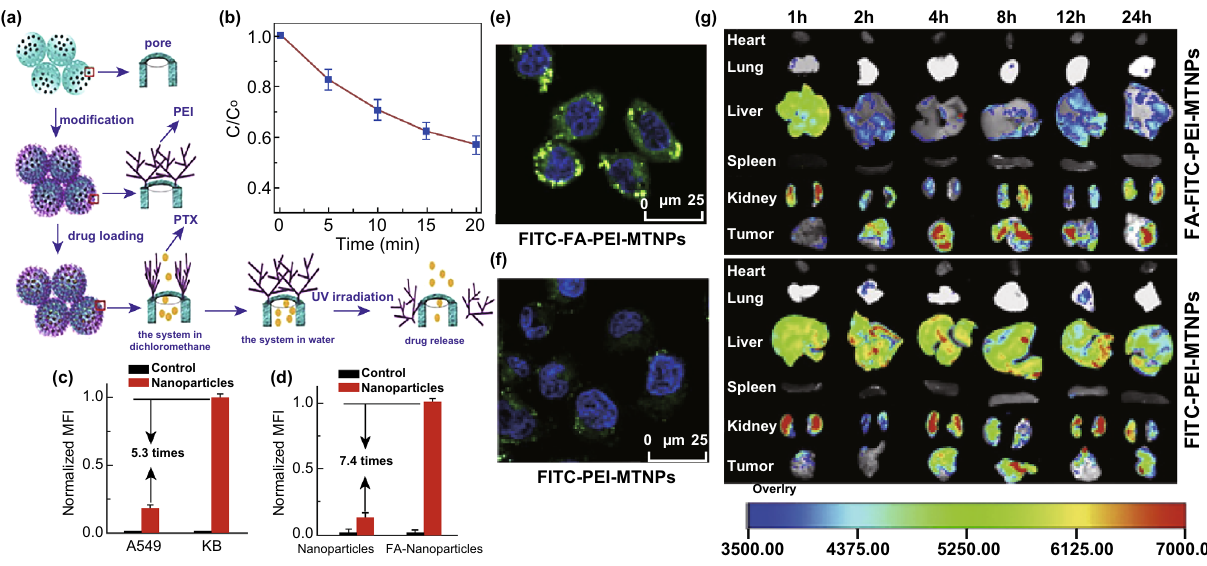
Fig. 3 a Illustration of drug loading and the release process in multifunctional mesoporous TiO 2 nanocarriers conjugated with PEI and folic acid. b The photocatalytic degradation of folic acid‑PEI on the surface of mesoporous TiO 2 nanocarriers through the use of UV light irradiation. c The improved cellular internalization of the nanocarriers into KB and A549 cells after 5 h (I) and the number of internalized nanocarriers with and without folic acid conjugation (II). FCM: Flow cytometry measurements. d Fluorescence images of treated KB cells after incubation (I) with and (II) without folic acid‑conjugated nanocarriers. The punctuated green colors indicate the nanocarriers and blue (color) shows the cell nuclei. e In vivo fluorescence images of tissue collected at different times (post‑injection). Adapted from Ref. [8] with permission from the Elsevier. (Color figure